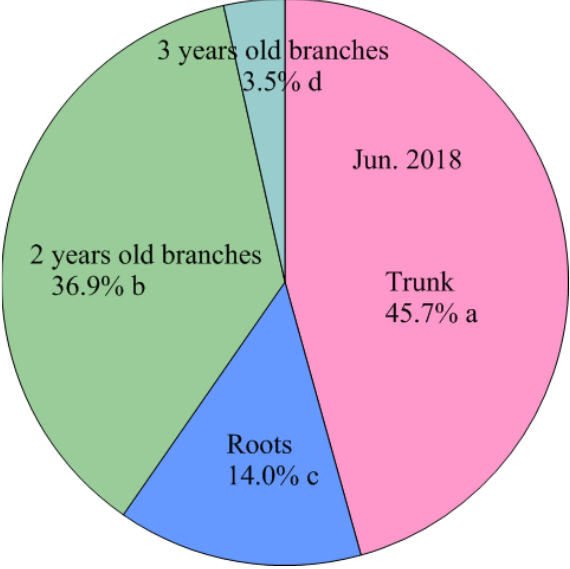
Figure 5. The ratio of N 2016&2017 supplied by each perennial structure of pear trees to total remobilized N 2016&2017 in spring of 2018. N 2016&2017 means amount of fertilizer-N derived in 2016 and 2017. Different small letters indicate significant differences ( p < 0.05) among organs.